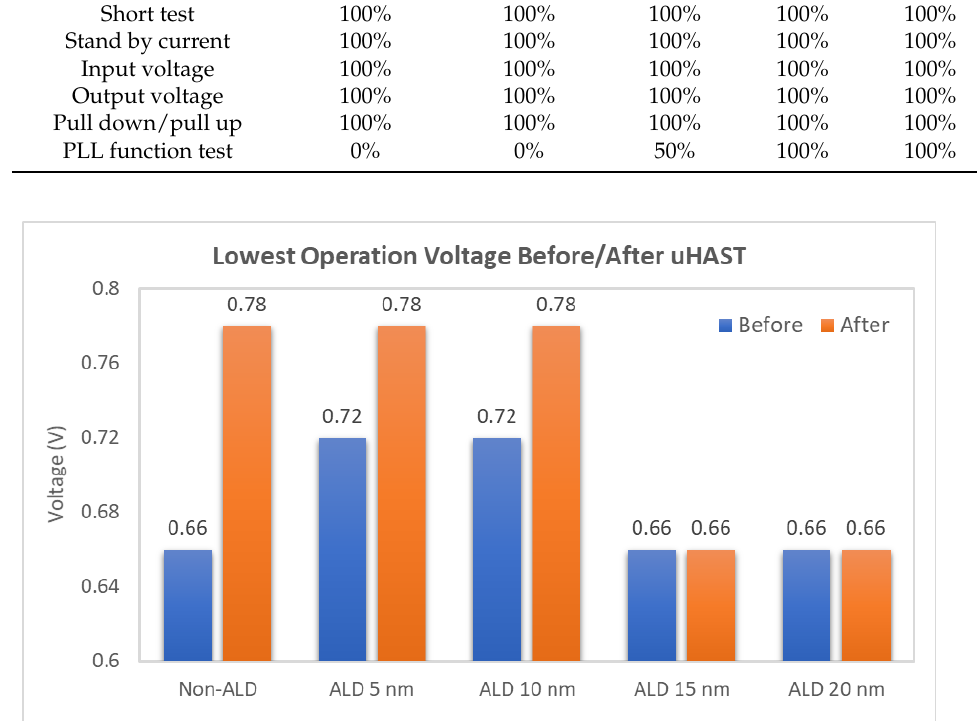
Figure 7. The Al 2 O 3 thicknesses versus the lowest operating voltage results before and after the 1000 h uHAST.